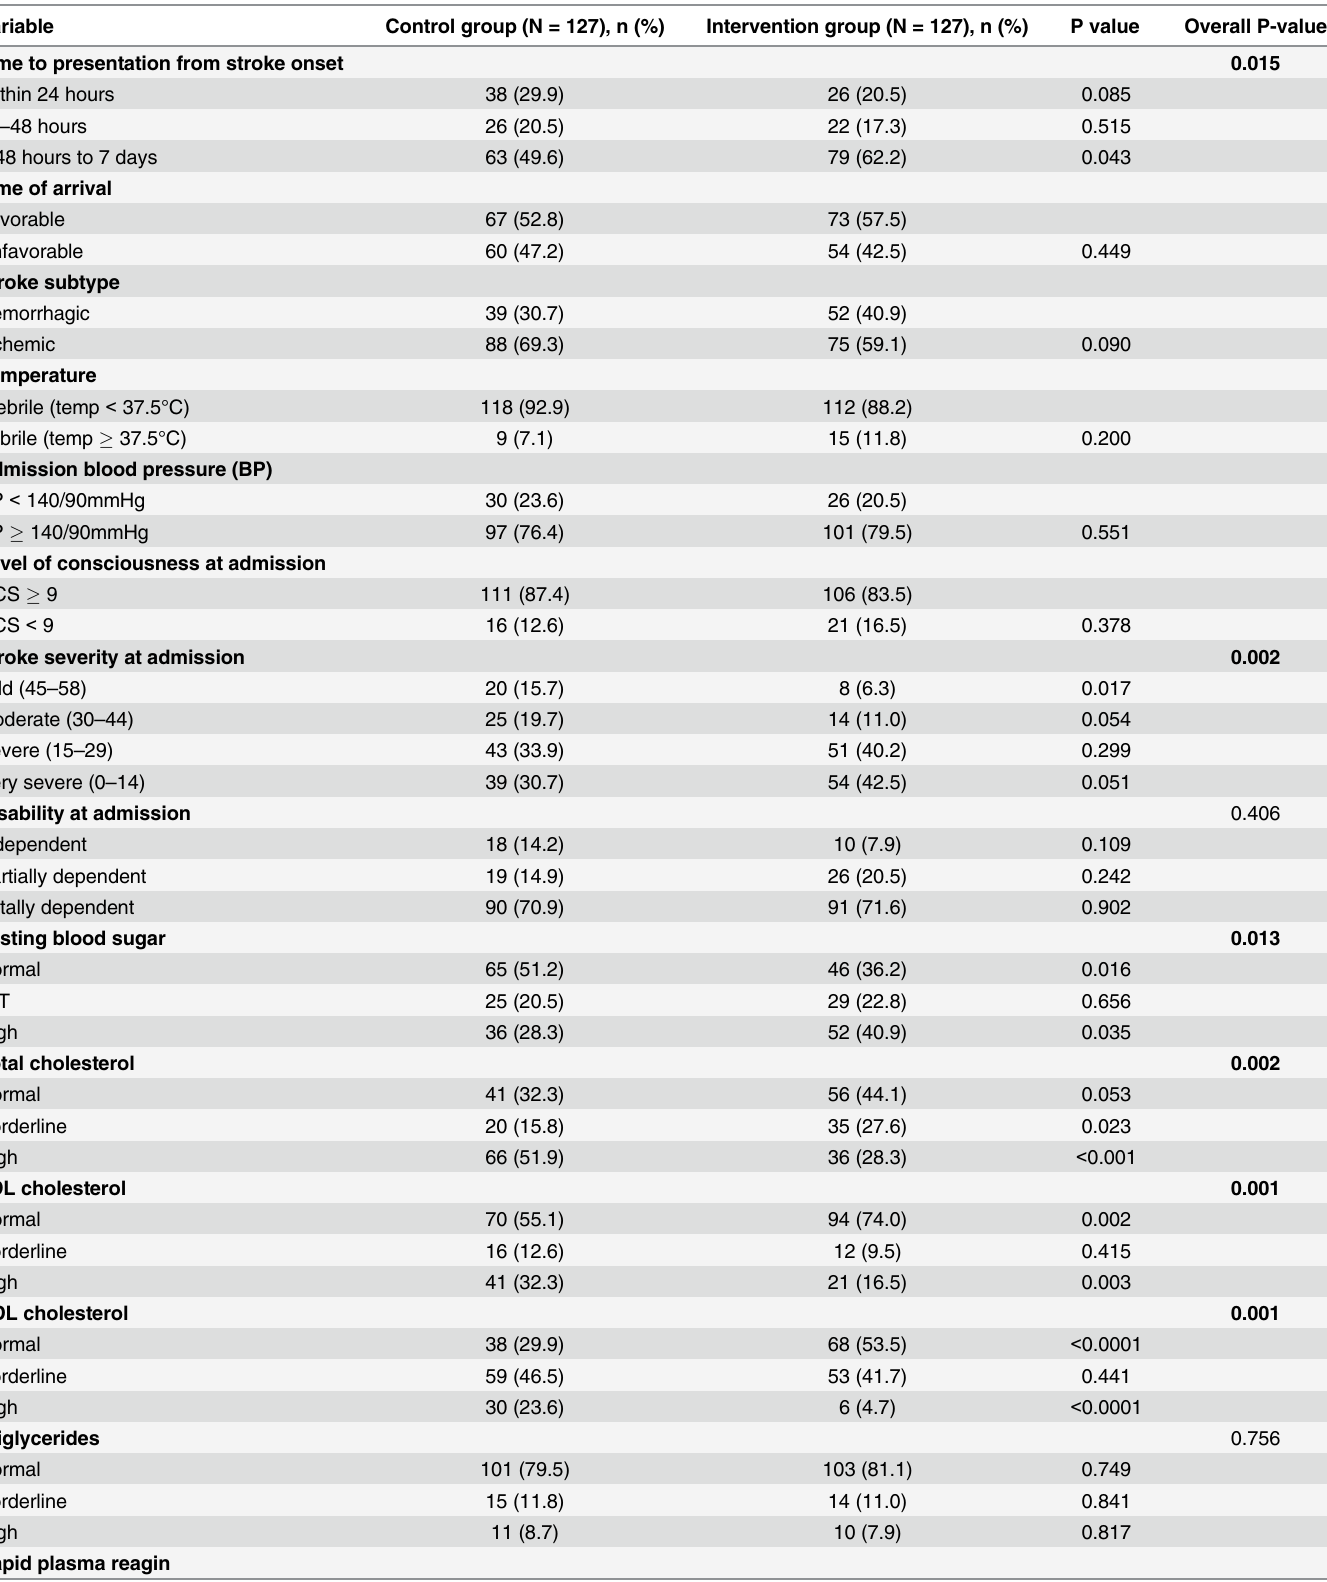
Table 3. Clinical and laboratory characteristics of the study